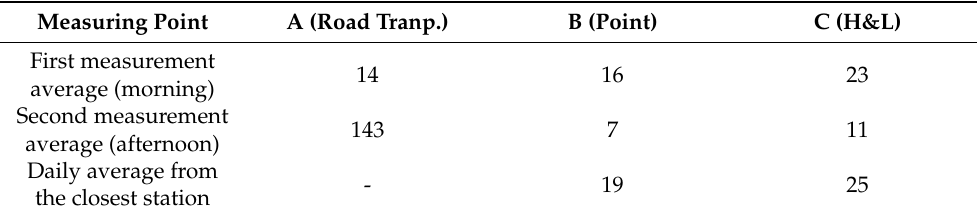
Figure 12. Mass concentration of PM10 in Poznan (own study).